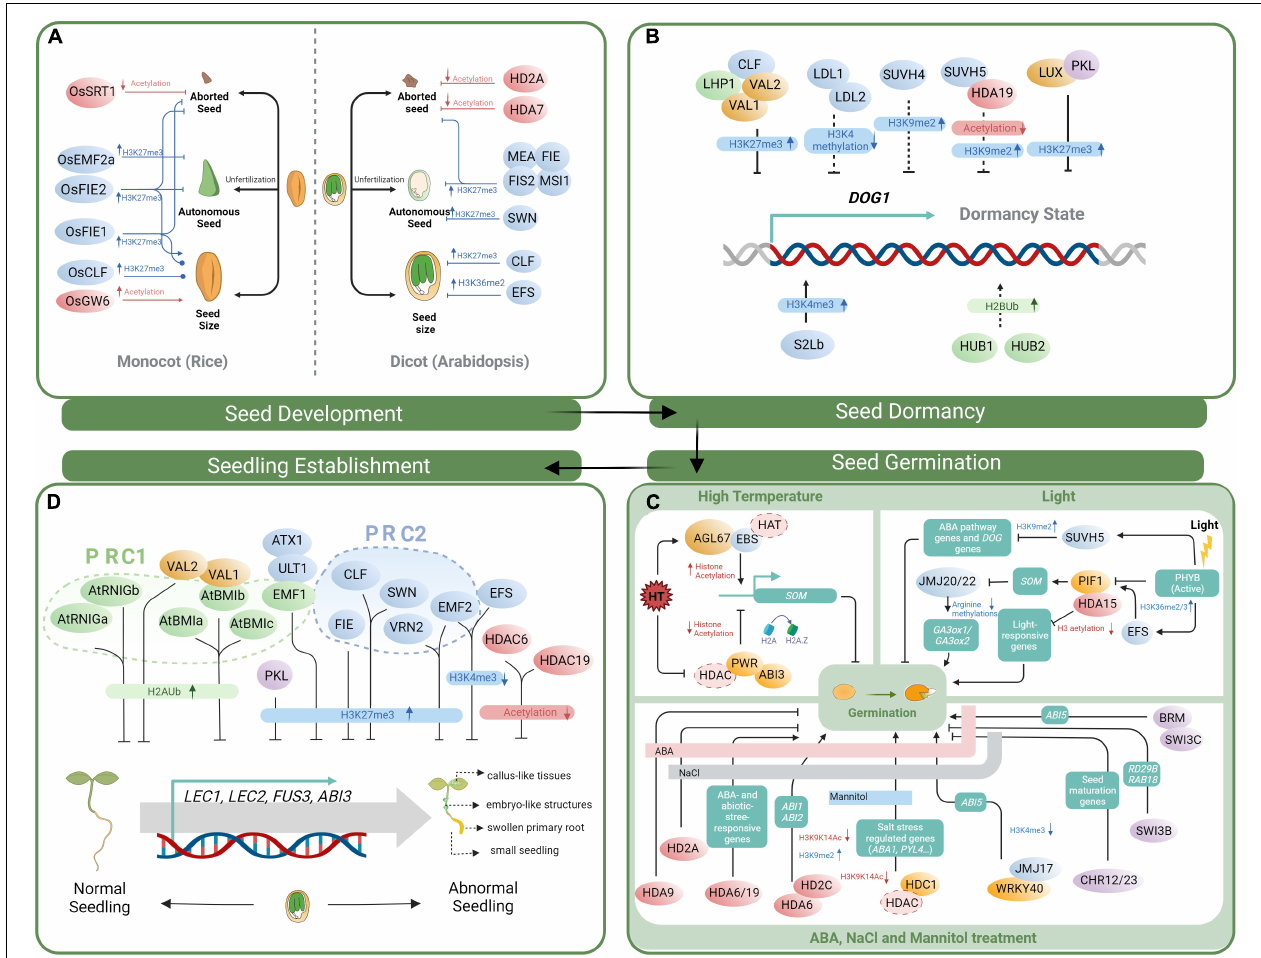
FIGURE 1 | Model of histone modification and chromatin remodeling during various stages of the seed life cycle. (A) Epigenetic regulators act of pivotal seed development in Arabidopsis and rice. Line with a dot in tail end represent an unclear regulatory pathway. (B) Chromatin regulation of seed dormancy through mediating the expression of DOG1 . Solid lines represent regulator that can modulate DOG1 expression directly. Dash lines represent those regulatory mechanisms that are still unclear. (C) The roles of histone modifiers and chromatin remodelers in regulating seed germination in response to light, temperature and abiotic stress. In the box below, the bold line with pink, gray and blue colors represent ABA, NaCl and mannitol treatment, respectively. Ellipse with dotted outline represents that the specific regulator is not clear. (D) Epigenetic factors act in seed-to-seedling transition. Illustrated histone modifiers and chromatin remodelers act in repression of ectopic expression of LAFL genes, thereby maintaining normal vegetative morphology of seedlings. The histone modifiers for histone acetylation, methylation, and ubiquitination are marked in red, blue and green, respectively. Chromatin remodelers and epigenetic associated regulators are marked in purple and orange, respectively. Downstream genes are shown in boxes with aquamarine